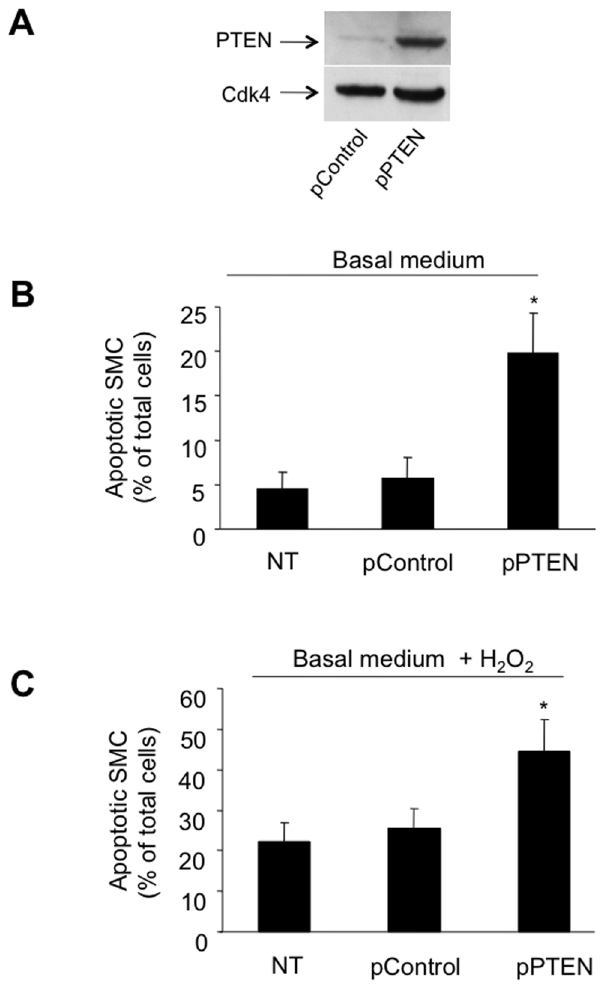
Figure 3. PTEN overexpression augments SMC apoptosis under basal conditions as well as following exposure to oxidative stress. HcASMC transfected with a plasmid carrying WT-PTEN or a control (empty) vector and PTEN protein-expression levels were determined by immunoblotting ( A ). SMC were incubated in basal medium ( B ) and in basal medium supplemented with H 2 O 2 ( C ) and the relative number of apoptotic cells was evaluated following TUNEL- staining (expressed as % of total cells; * P , 0.001; n=6). HcASMC were transfected as follows: non transfected (NT); transfected with an empty plasmid without PTEN-cDNA (pControl); transfected with a plasmid coding for PTEN (pPTEN).